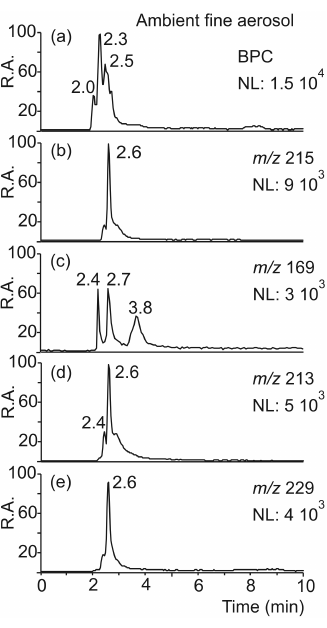
Figure 1. Selected LC–MS chromatographic data using RP-LC obtained for ambient fine aerosol, including a base peak chro- matogram (BPC) and extracted ion chromatograms (EICs) at m/z 215, 169, 213 and 229, corresponding to organosulfates related to isoprene ( m/z 215; 2-sulfooxy-1,3,4-trihydroxy-2-methylbutane) and OSs related to 2- E -pentenal and indirectly to 2- E -hexenal and 3- Z -hexenal ( m/z 229, 213, and 169). The retention times of the solvent front (containing unretained material) and sulfuric acid, which can be seen in the BPC (a) , were 2.0 and 2.3 min. For the molecular structures of the m/z 229, 213, and 169 organosulfates, see Table 2. Abbreviation: NL, normalization